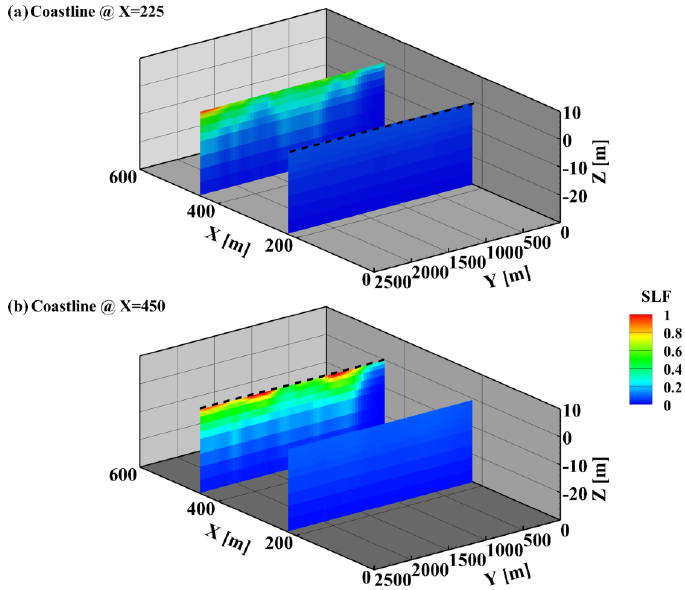
Figure A1. Contours (color scale on the right) of peak SLF ( t = 8 . 4h) as a function of the vertical Z , cross-shore X , and alongshore Y coordinates for (a) a simulation with the coastline at − 0 . 5m ( X = 225m) and (b) a simulation with the coastline at 0m ( X = 450m). The dashed black lines mark the coastline in each respective simulation. The slice with high SLF values in panel (a) is not underneath the simulated coastline.